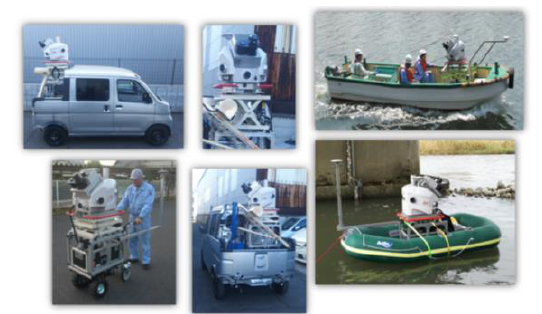
Figure 3. Developed system to achieve versatile mobile